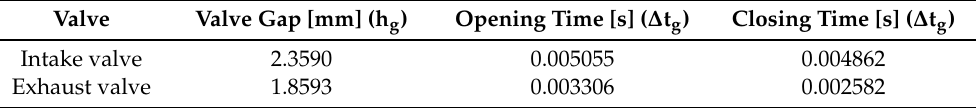
Figure 9. Valve lift curve detailing the modeling of the gap area as function of several exponents for the potential function α ( t ) . Table 4. Parameters of the valve gap modeling for the current computational